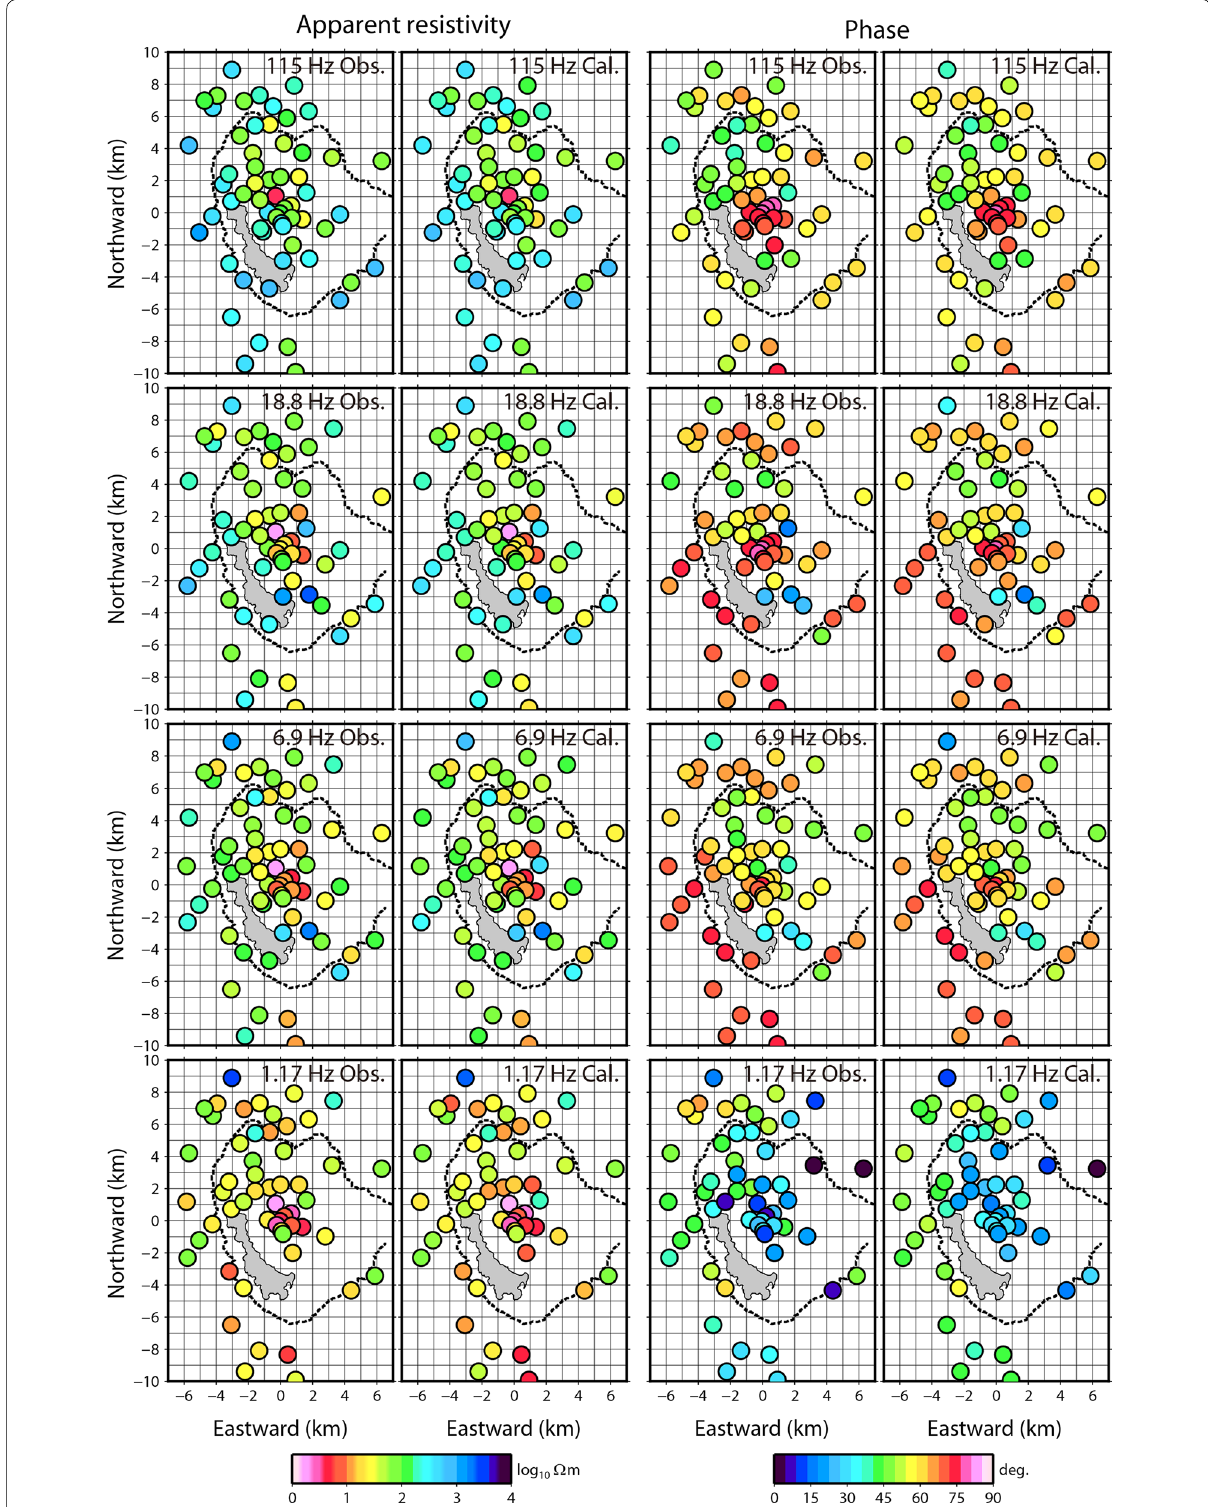
Fig. 2 Apparent resistivity and phase maps for the observed data (Obs.) and calculated responses (Cal.) from the best‑fit resistivity model (Figs. 4, 5) for four frequencies (1.17, 6.9, 18.8 and 115 Hz). The responses shown here were calculated from the sum of the squared elements’ invariant imped‑ ances. See the text for more details. The dotted line indicates the caldera rim, and the shaded region marks the surface extent of Lake